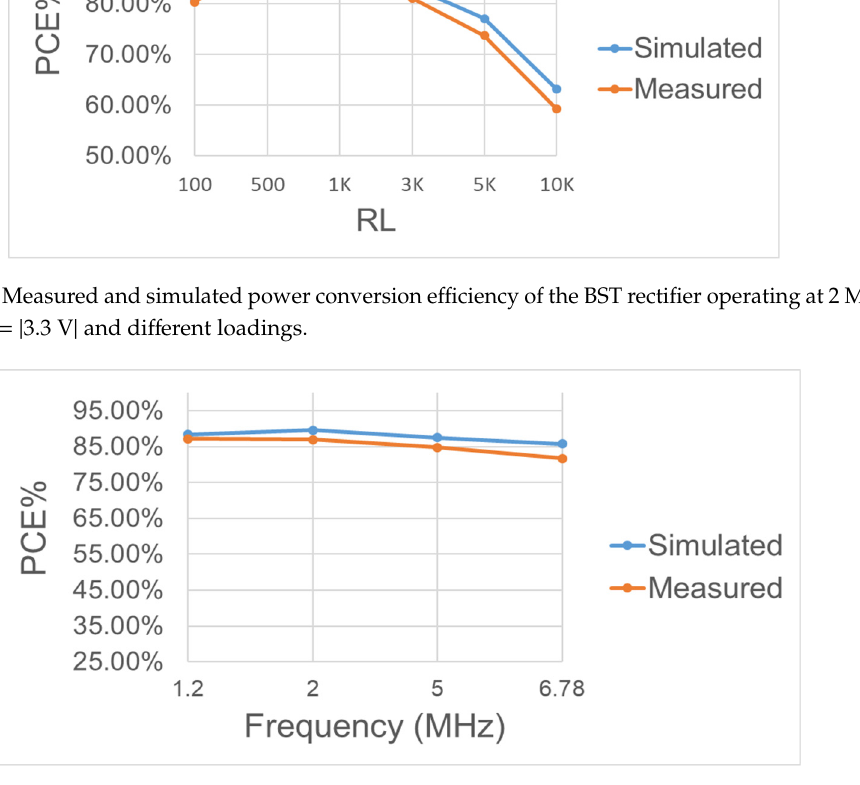
Figure 35. Measured and simulated power conversion efficiency of the BST rectifier operating at different frequencies with VAC = |3.3 V|, 𝑅 (cid:3013) = 1 kΩ .